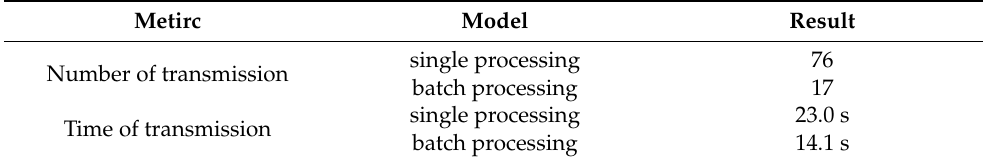
Table 8. Comparison of execution time by different processing. Metirc